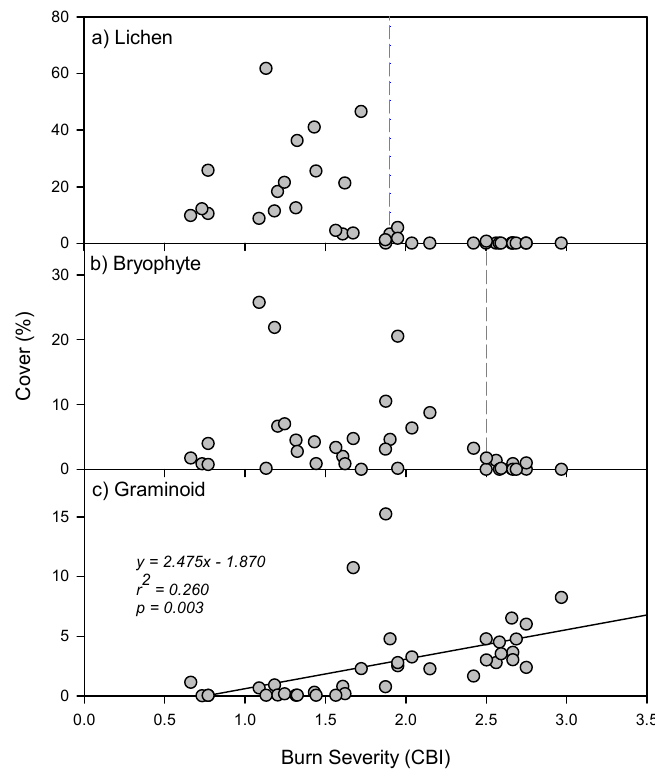
Figure 5. Relationships between the cover of plant groups and burn severity as measured by the Composite Burn Index (CBI) for ( a ) lichens, ( b ) bryophytes and ( c ) graminoids. The thresholds for lichen cover at 1.9 CBI and bryophyte cover at 2.5 CBI were determined from regression tree analysis at a significance level of p < 0.05. Table 1. Significant indicator species with an indicator value > 25 for each burn severity class as determined by the method of Dufr ê ne and Legendre [33]. Each species was only tested for significance in the group for which it had its maximum indicator value.